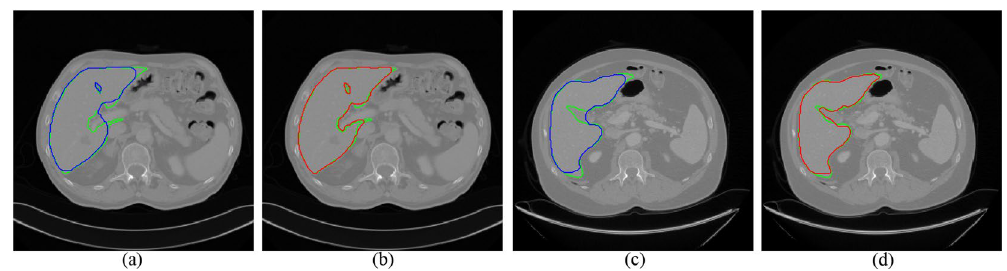
Figure 6. Two examples of segmentation results by different methods. The ground truth is shown in green curves. ( a ) and ( c ) Segmentation using original graph cut (blue curves). ( b ) and ( d ) Segmentation using the proposed method (red